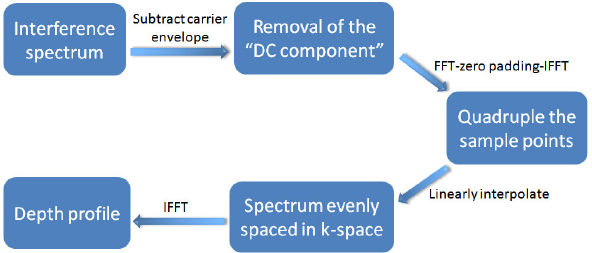
Fig. 4. Diagram of the SD-OCT post-processing